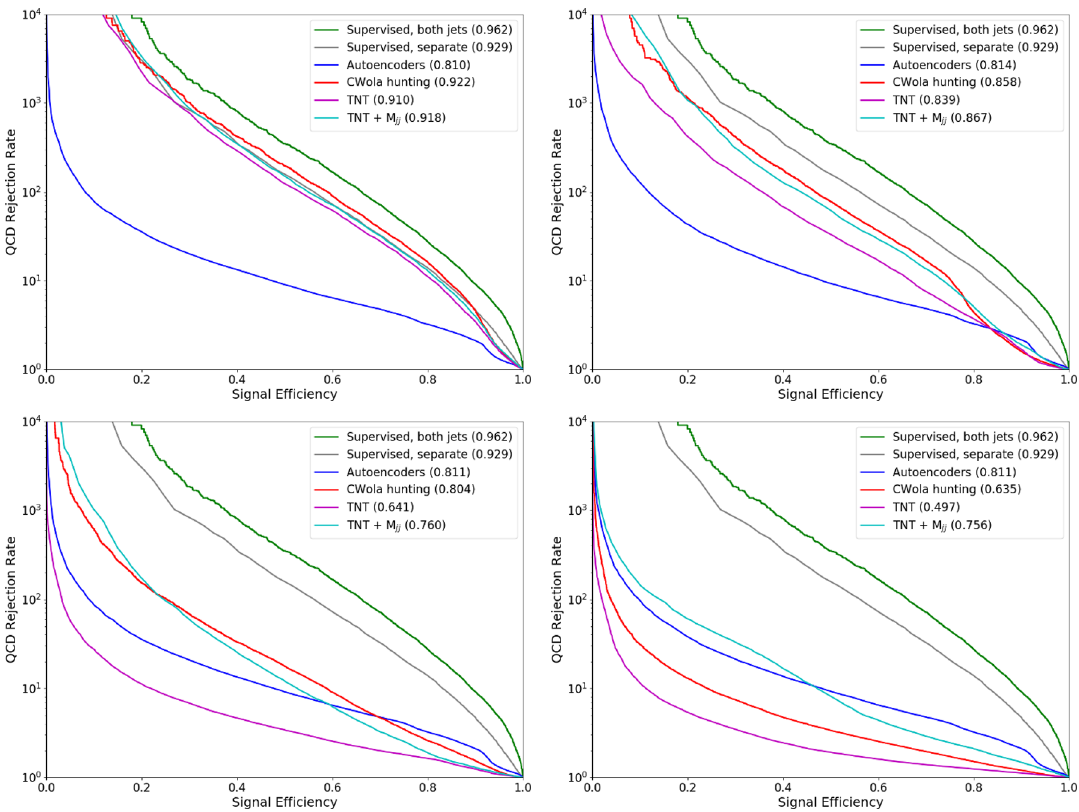
Figure 2 . Classification performance for distinguishing signal and background events. The numbers next to each label show the Area Under Curve (AUC) of each classifier. We show results for when the fraction of signal events is 9%, 1%, 0.3% and 0.1% in the top left, top right, bottom left and bottom right respectively. We show the performance of the Tag N’ Train technique with and without the dijet mass cut, and the CWoLa hunting and autoencoders. Two fully supervised classifiers trained with ground-truth labels, are shown for reference. The one labeled ‘separate’ consists of 2 classifiers, trained on each jet separately and combined in the same way as the TNT classifiers, and the one labeled ‘both jets’ is trained on both jets at the same